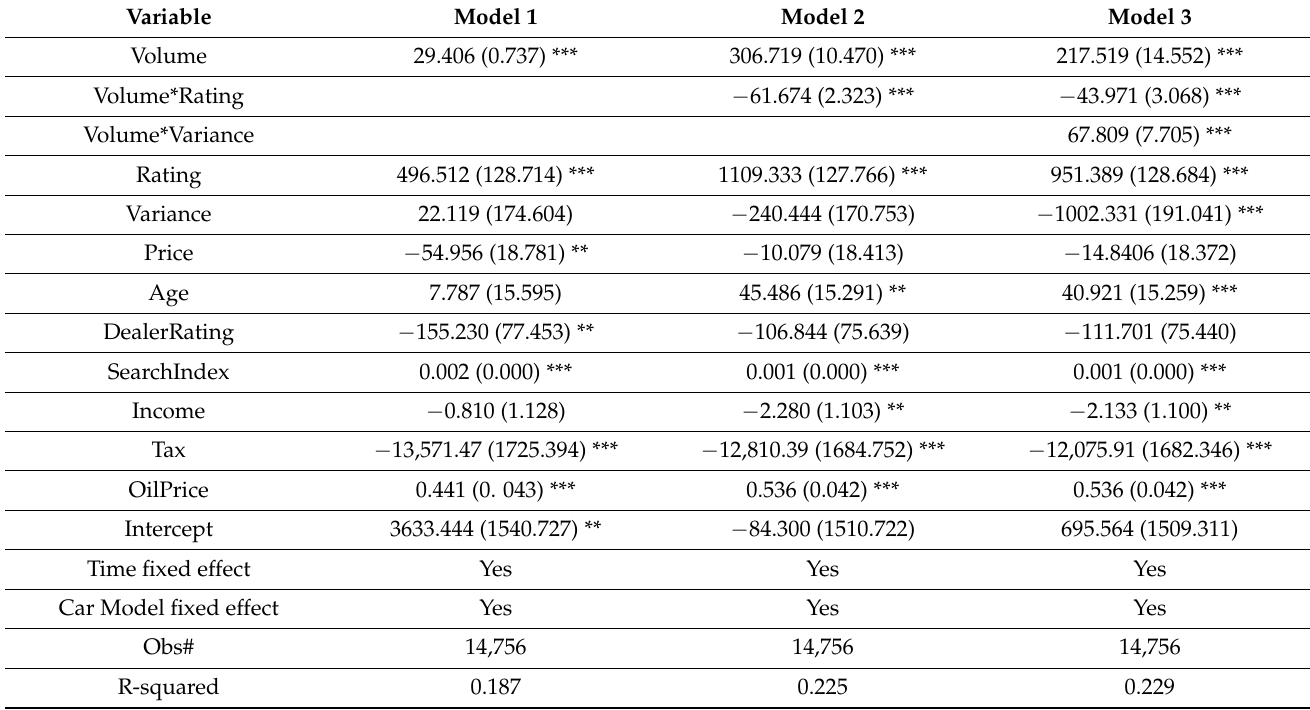
Table 6. Effects of eWOM on car